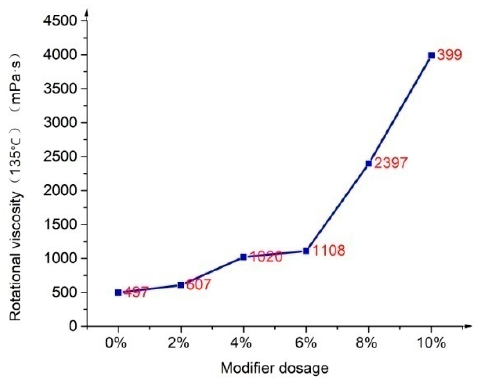
Figure 4. Rotational viscosity (135 °C).